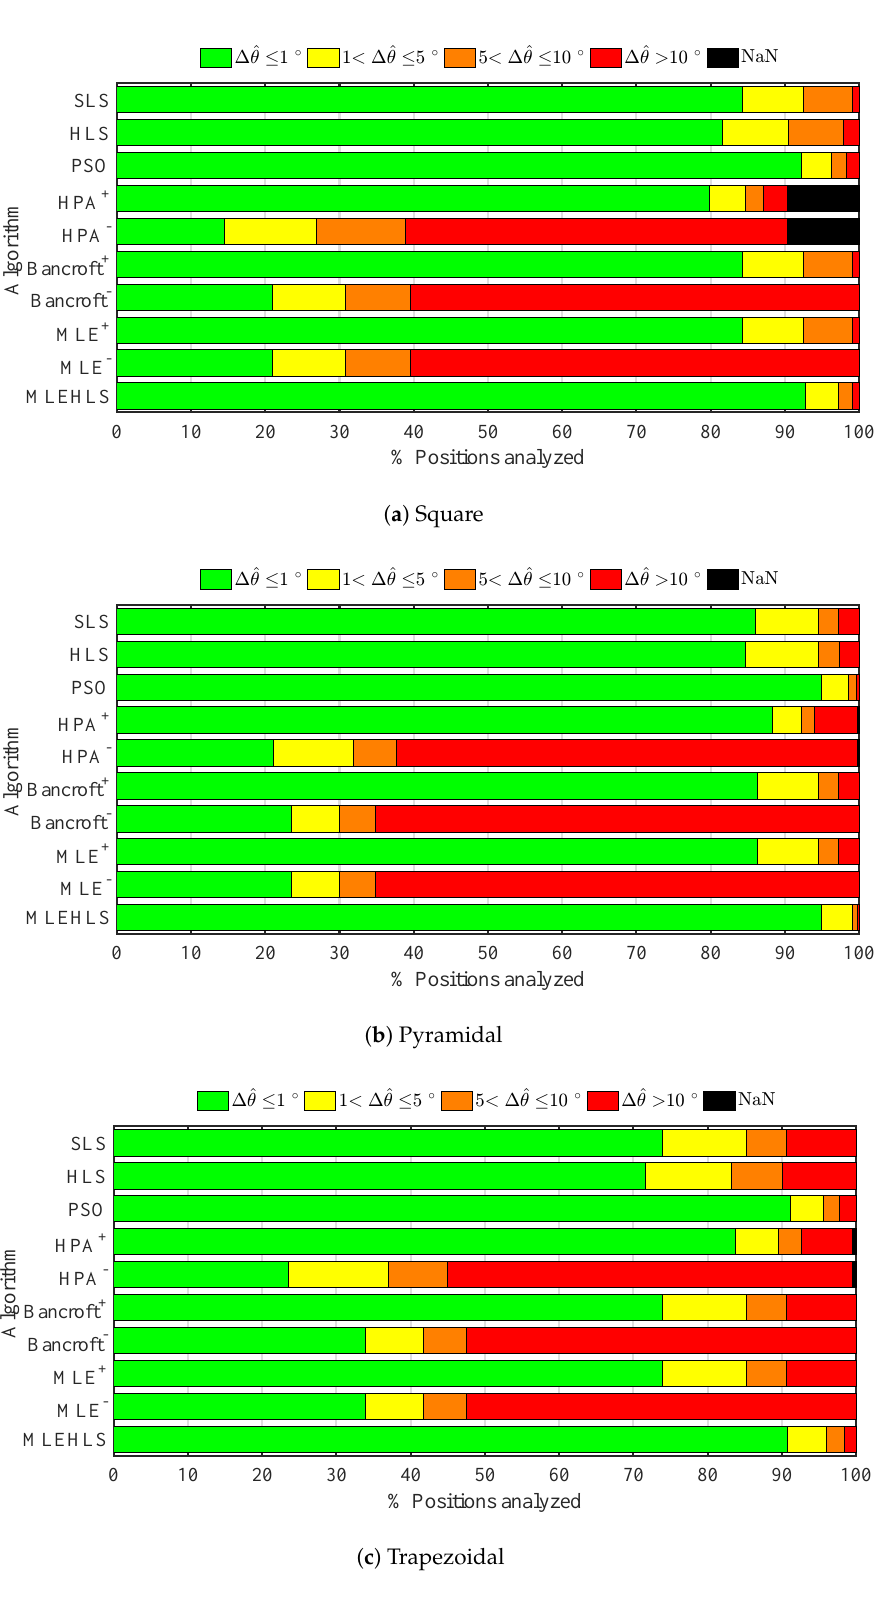
Figure 9. Percentage of positions located within errors bands in the elevation angle ∆ ˆ θ under time sampled digitizing error for each algorithm and antenna array